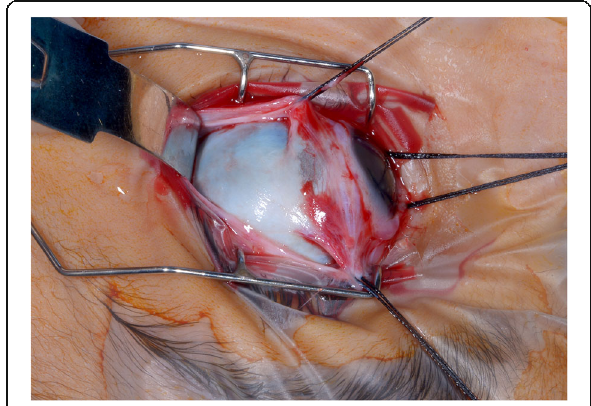
Fig. 2 Exposed sclera following 360 degree peritomy demonstrating blue/grey hue due to scleral